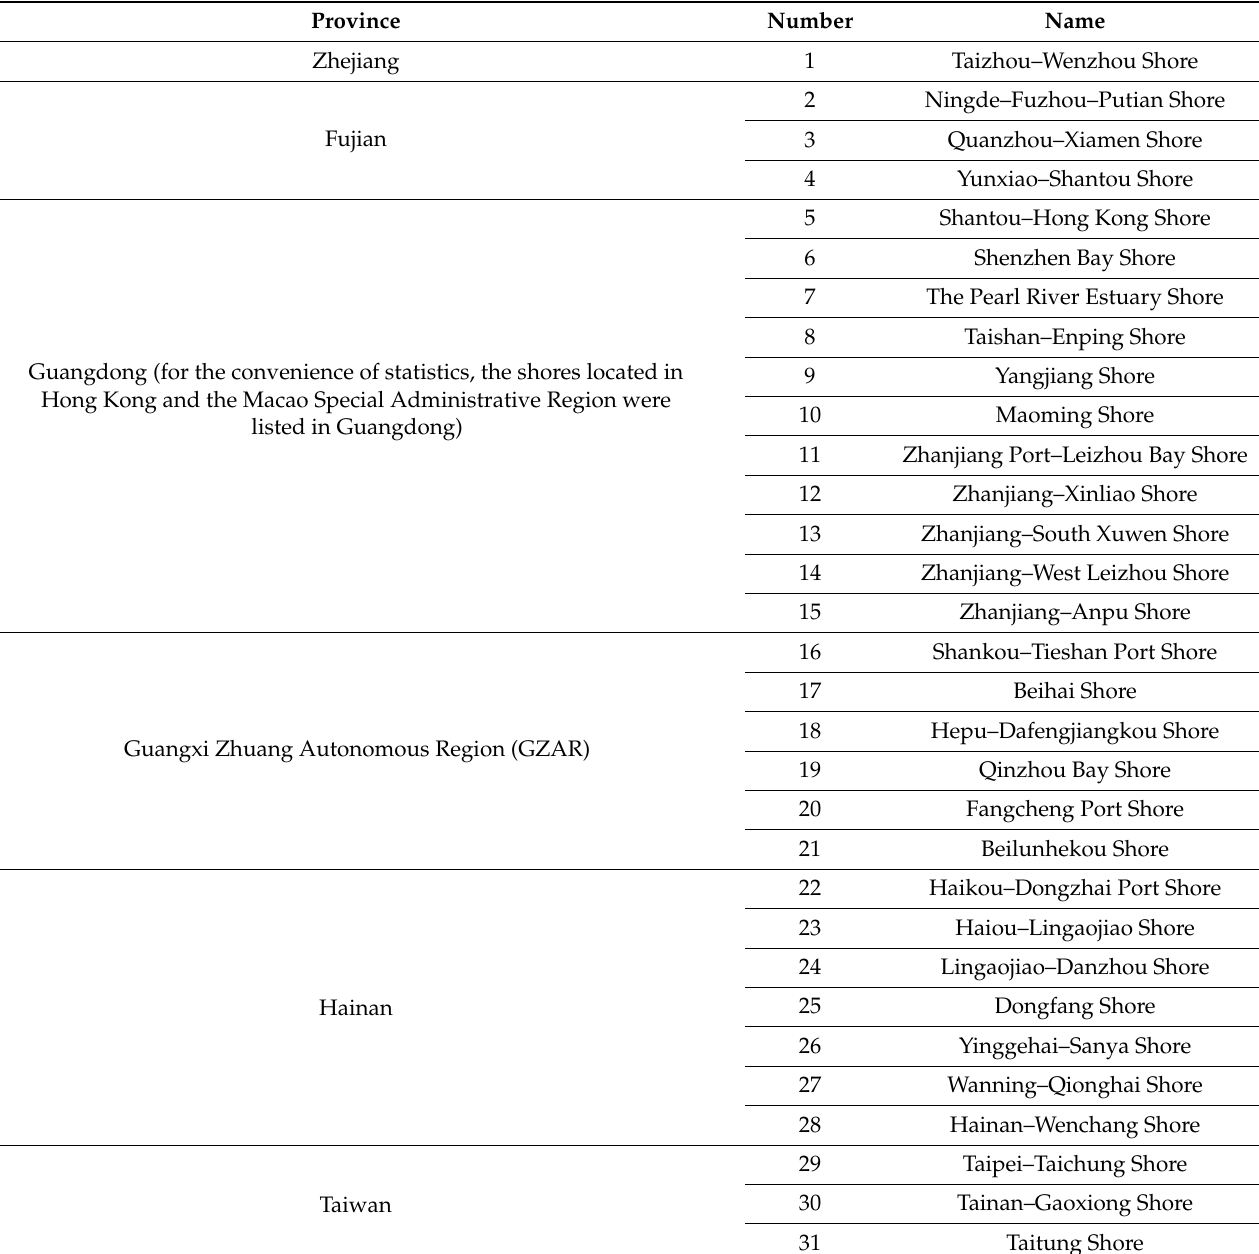
Table 1. Basic information for China’s mangrove monitoring